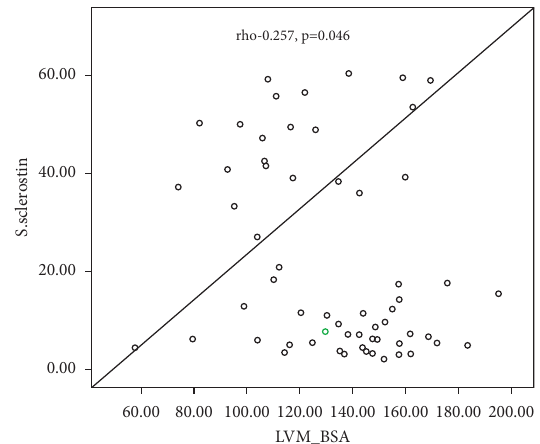
Figure 3: Linear negative correlation between the left ventricular mass index and serum sclerostin level.